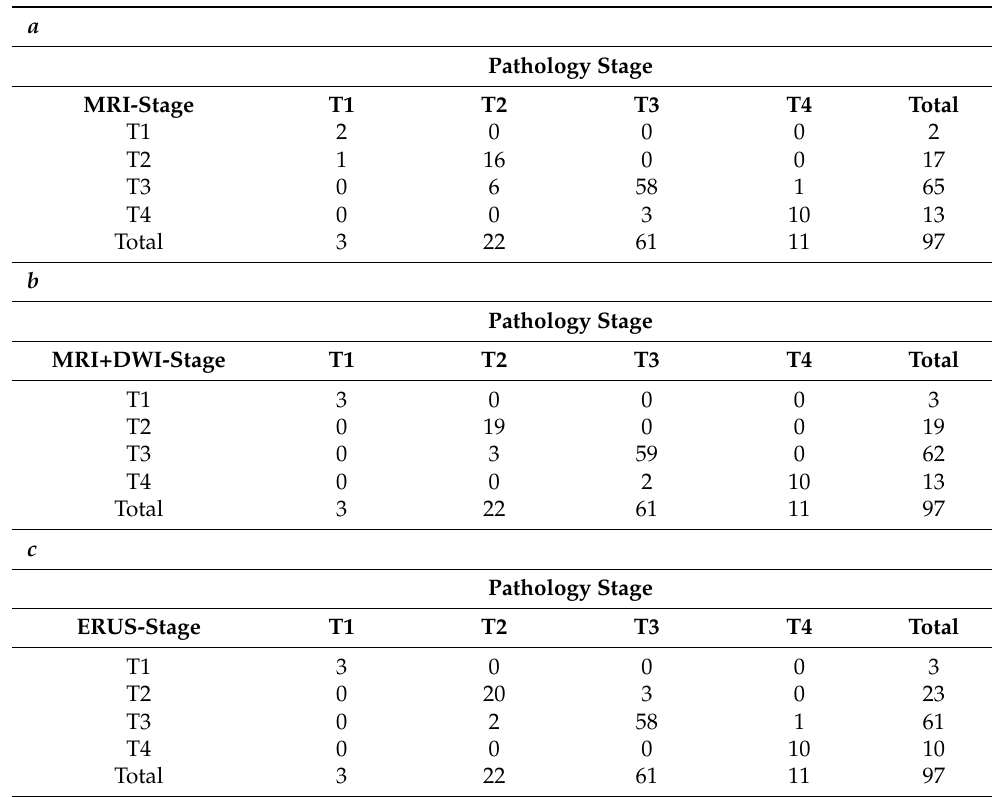
Figure 1. The diagram summarizes the exclusion criteria adopted to obtain a homogeneous population in relation to the type of treatment received. TEM: transanal endoscopic microsurgery; TME: total mesorectal excision; CRT: chemo-radiotherapy. Table 1. Preoperative staging was obtained from different imaging modalities and compared with the post-surgical pathology results. The radiological assessment for each tumor stage obtained with MRI ( a ), DWI ( b ), and ERUS ( c ) were evaluated according the AJCC/TNM 8th Ed. [10].